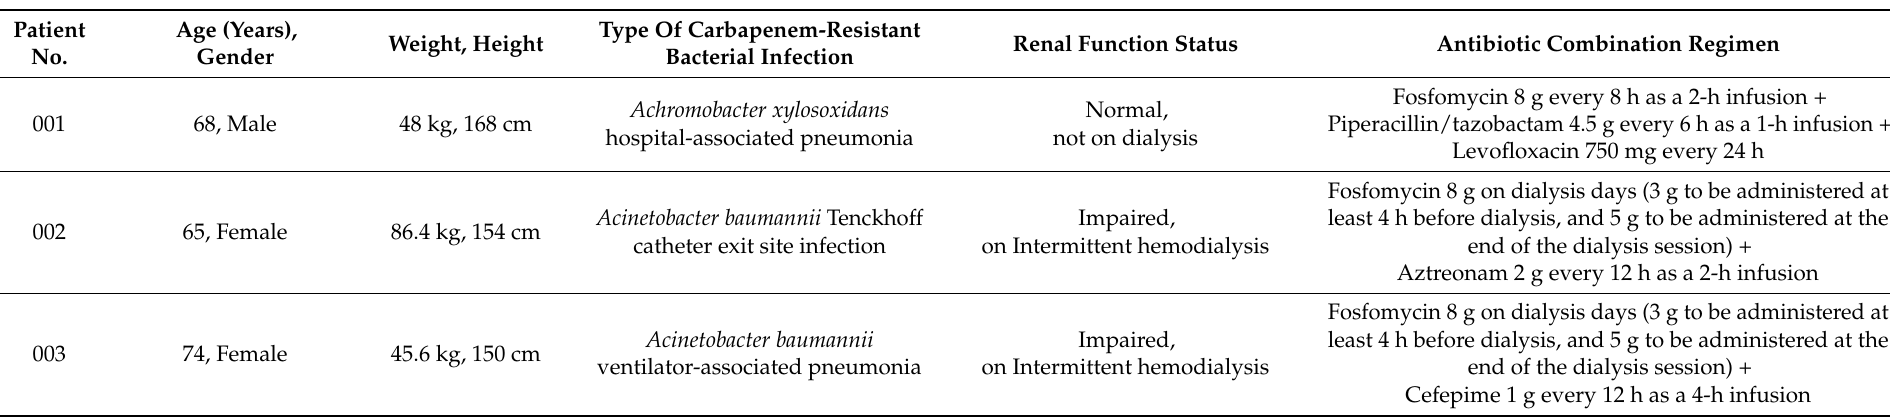
Table 4. Clinical characteristics of the four patients on fosfomycin-based combination therapy for carbapenem-resistant bacterial